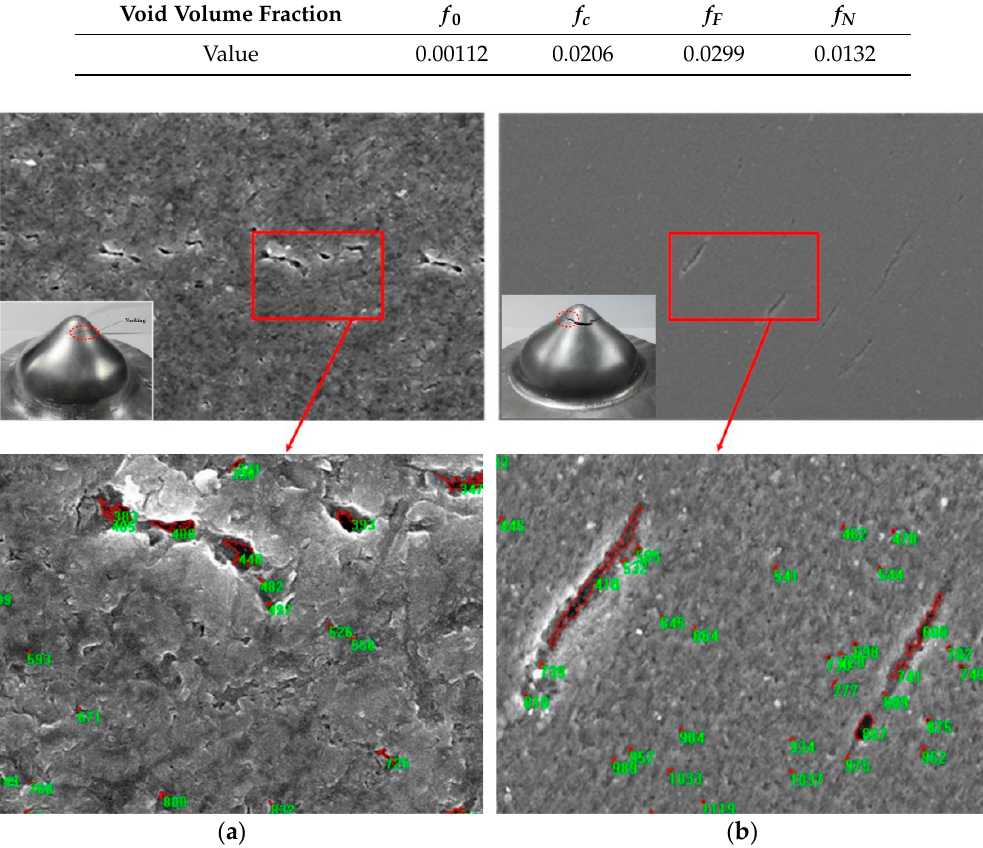
Figure 7. The calculation of void area percentage: ( a ) the voids coalescence stage; and ( b ) the fracture stage.